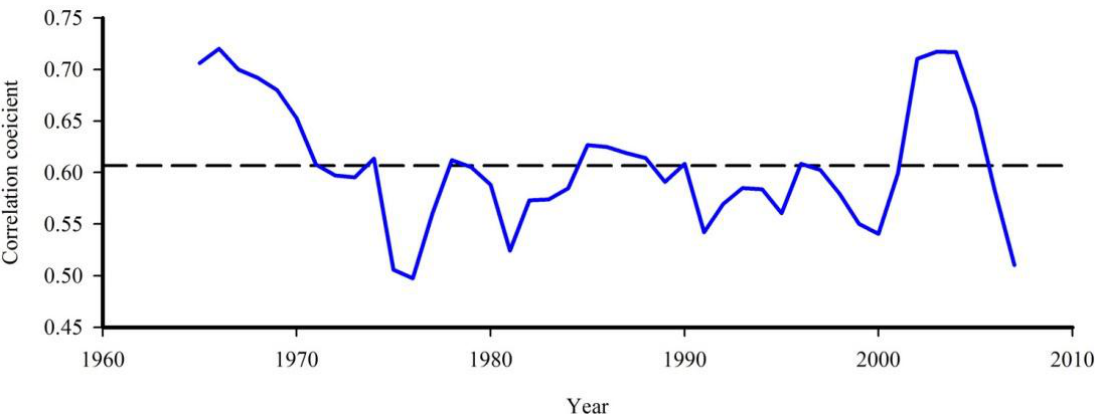
Figure 5. Result of the 21-year moving correlation between the PC#1 RW and PDSI p6-7 during instrumental period (1955–2016).